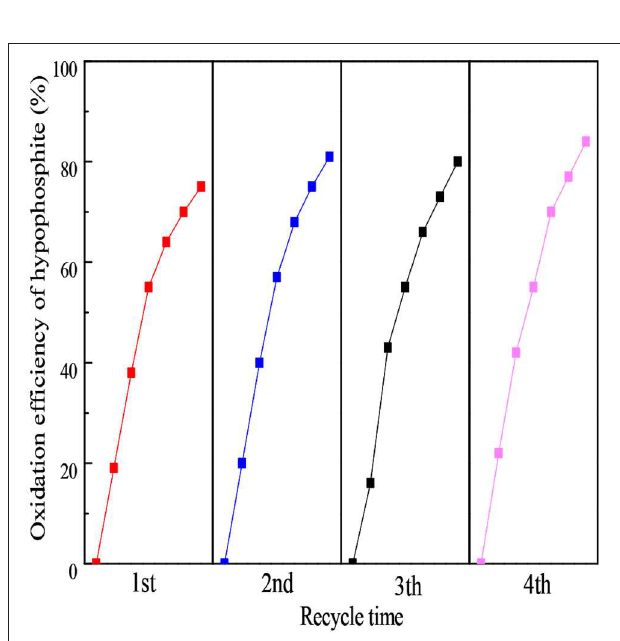
FIGURE 7 | The stability analysis of the 160-Ti 4 O 7 /g-C 3 N 4 photocatalyst under repetitive